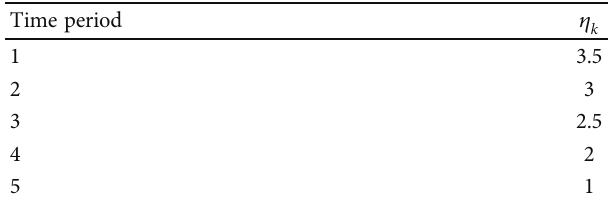
Table 1: Price elasticity coe ffi cient η